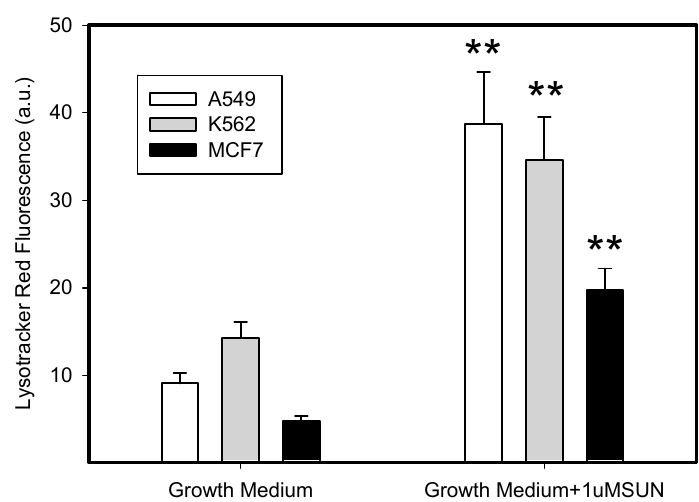
Figure 5. The effect of SUN on the lysosomal sequestration capacity of cancer cells. Cells were cultured for 3 days in the presence of 1 μ M SUN under standard conditions. Cells cultured in medium without SUN were taken as controls. The lysosomal sequestration capacity of cells was analyzed using flow cytometry upon staining with Lysotracker Red. Columns represent the means and standard deviations of four independent experiments. ** denotes a significant change in the mean fluorescence ( p < 0.01) between respective SUN-stimulated and SUN-unstimulated cells.